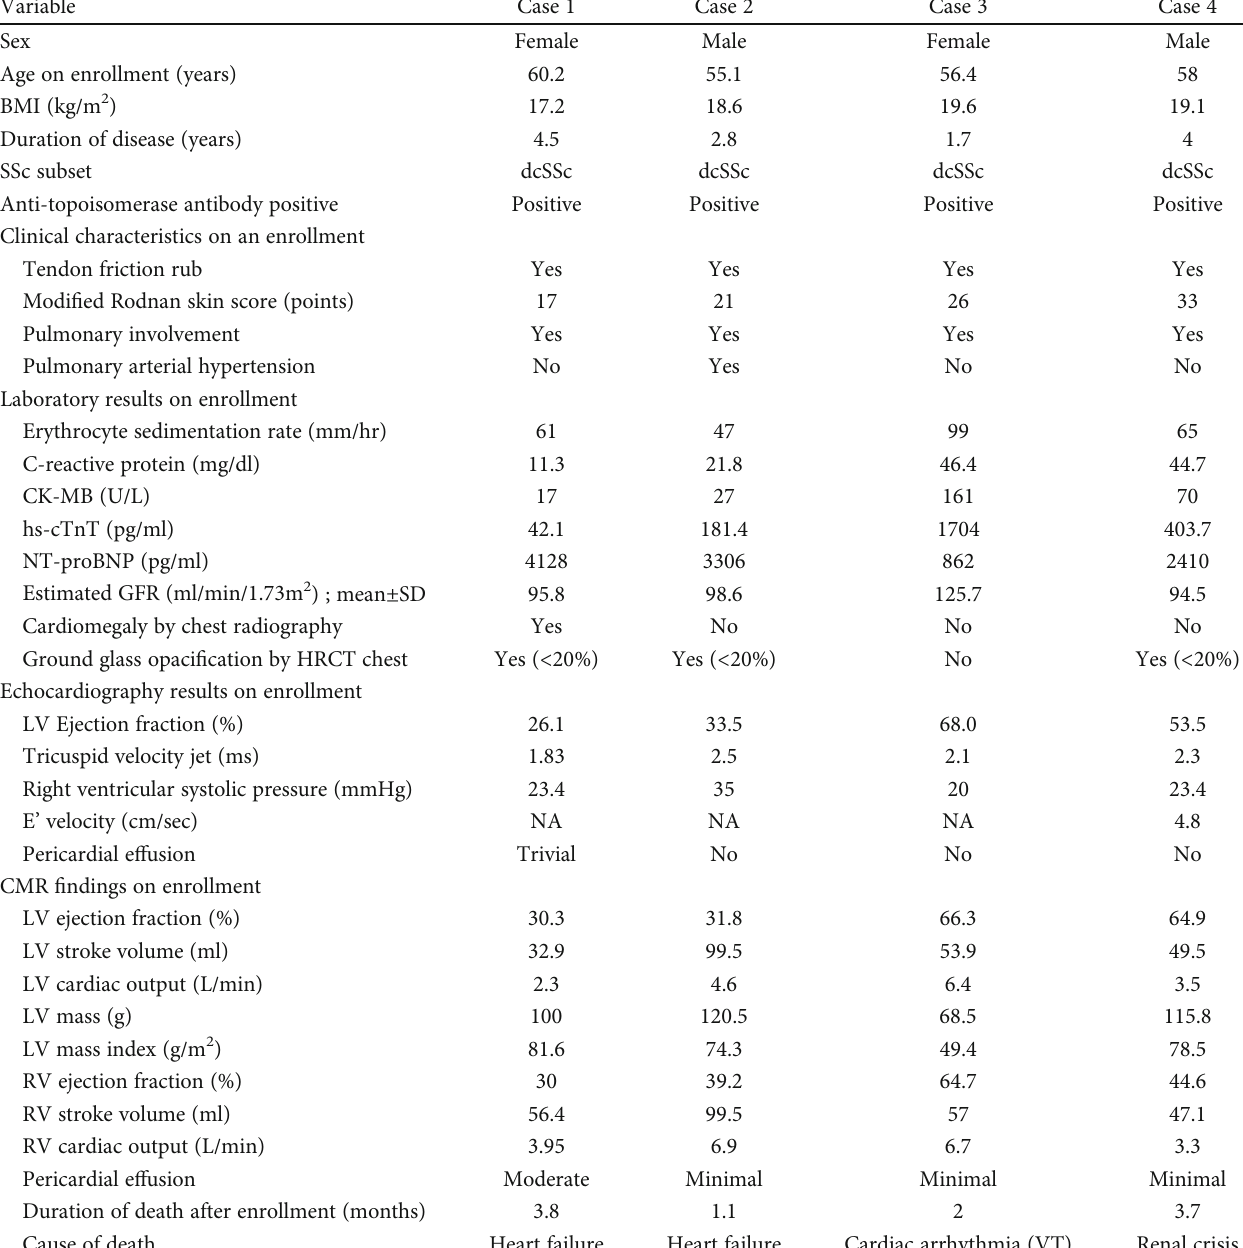
Table 4: Clinical data of patients who